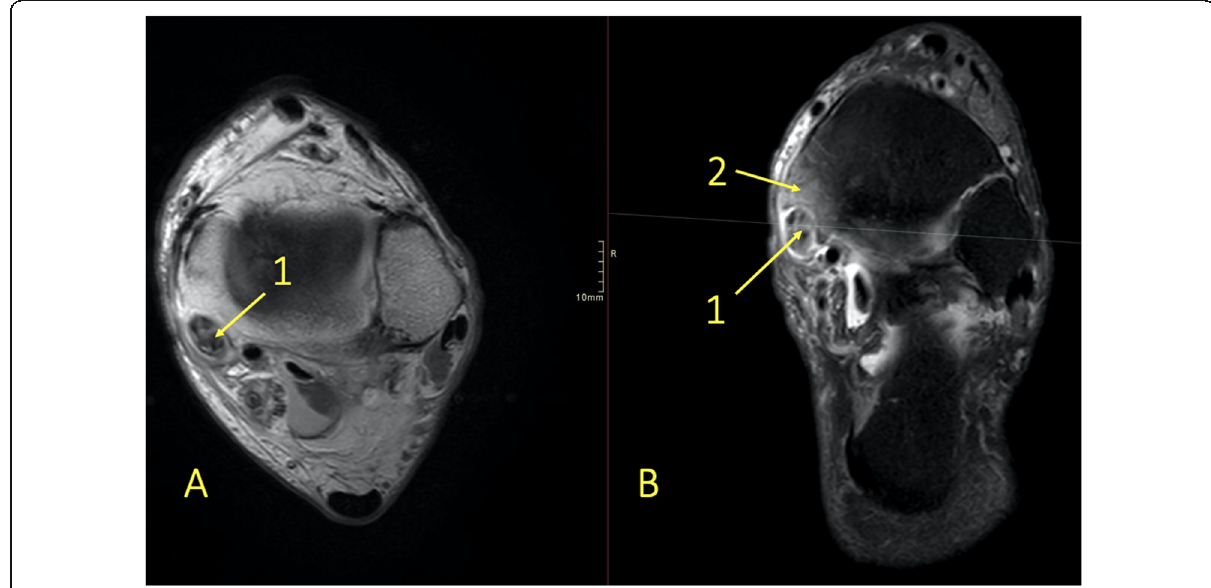
Fig. 8 A 65-year-old male with chronic ankle pain after ankle trauma about 3 weeks earlier and a suspected rupture of the tibialis posterior tendon. MRI showed tendinopathy. (1) A partial rupture of the tibialis posterior tendon and (2) BME in the medial malleolus were